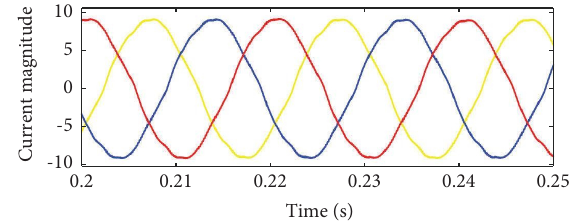
Figure 13: With the MHPSO approach, output current waveform.